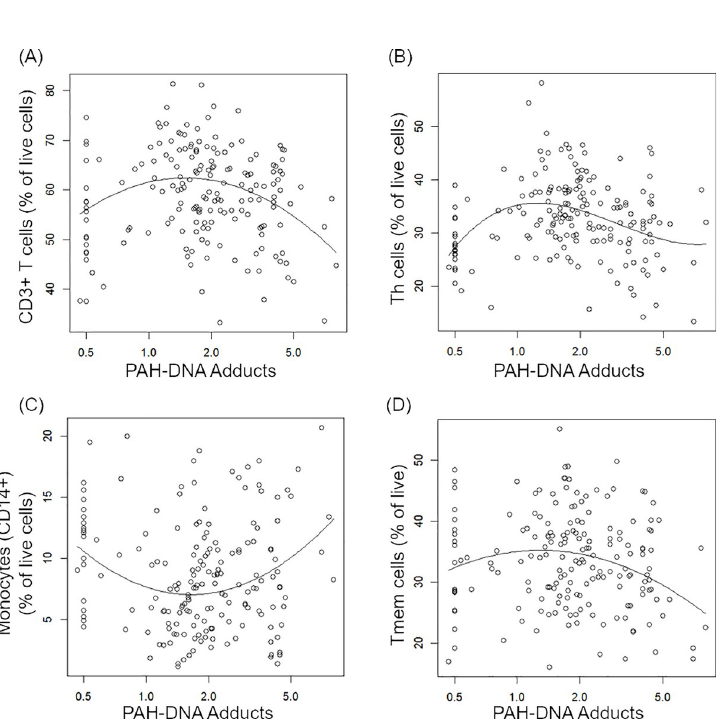
Fig 2. Covariate-adjusted associations between PAHs and cell surface markers. Individual data points represent observations; solid lines represent estimated mean outcome vs. PAH-DNA adducts adjusted for other variables in the model. The outcomes (A-D) were T (CD3+), Th (CD4+), monocytes (CD14+), and Tmem (CD3+CD45+) cells in logarithmic scale.